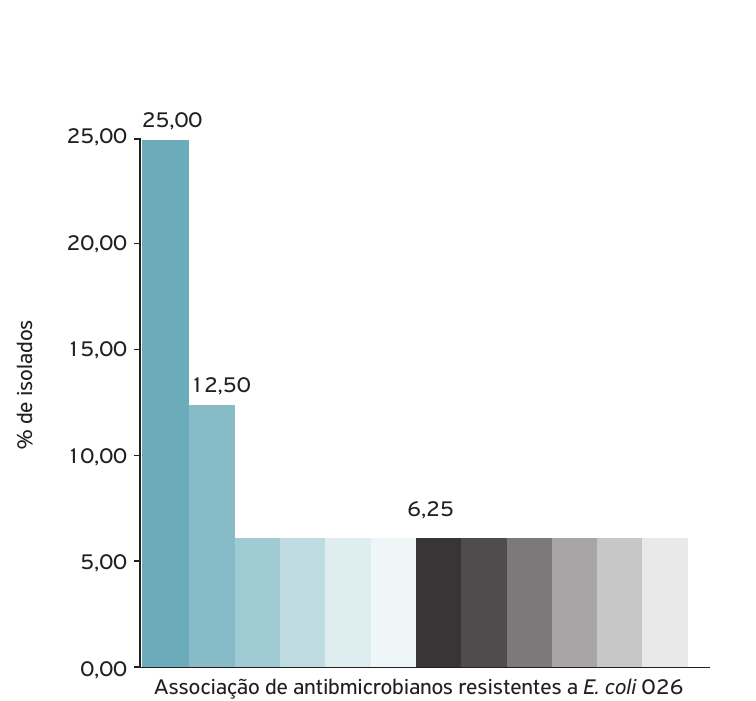
Figura 3. Perfil de multirresistência a antimicrobiano de E. coli